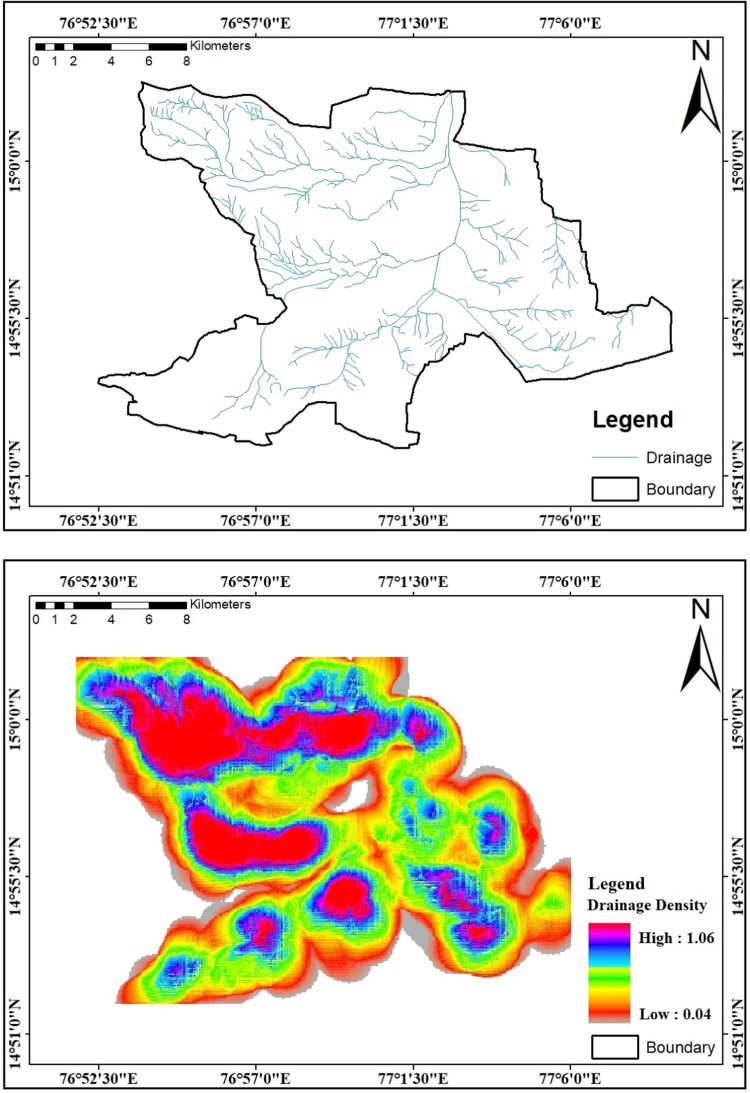
Drainage and density map of the study area in km/km2.